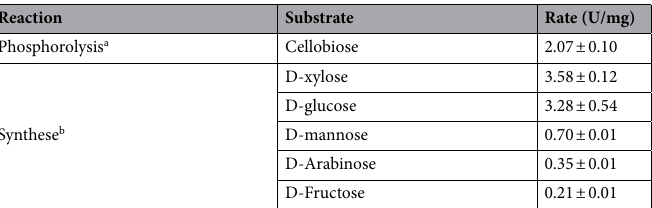
Table 1. Substrate selectivity of Cb CBP in the phosphorolytic and synthetic reactions. a The following substrates were less than 10% of relative activity in phosphorolytic reactions: maltose, cellotriose, cellotetrose, and trehalose (detailed data not listed). b The following acceptors were less than 5% of relative activity in synthetic reactions: D-sorbitol, D-mannitol, methyl-α-D-glucoside, L-arabinose, D-galactose, D-ribose, lactose, cellobiose, maltose, cellotriose, trehalose, and sucrose (detailed data not